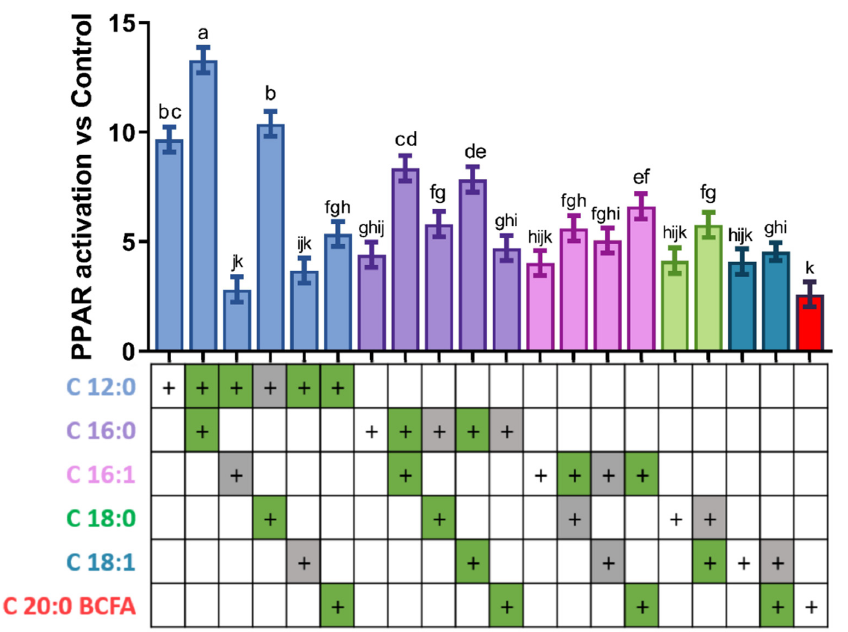
Figure 2. PPAR activation by combinations of two fatty acids. Compound doses are: C12:0, 500; C16:0, 158; C16:1, 158; C18:0, 190; C18:1, 158; C20:0 BCFA, 158 μ M. Dissimilar letters above bars refer to statistically significant ( p < 0.05) difference between each treatment when all pairwise comparisons are considered; green cells below the graph indicate significant differences ( p < 0.05) in PPAR activation between the mixture and the individual fatty acid within the mixture reported on the left, when individual fatty acid, while gray cells indicate no significant differences ( p > 0.05).